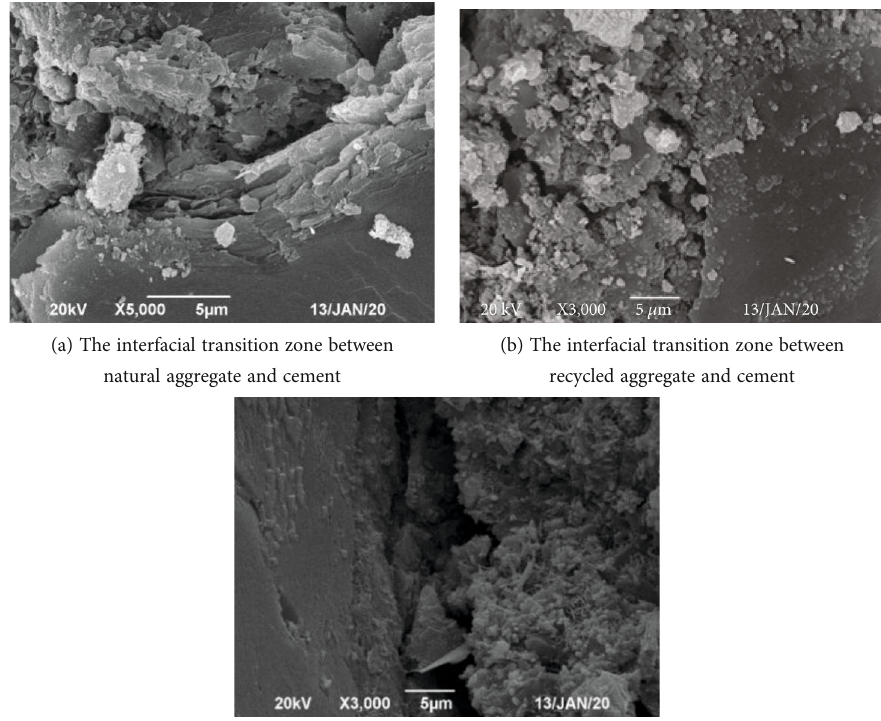
Figure 10: Microscopic morphology of the interfaces between the three aggregates and the cement paste (magni fi ed 3000